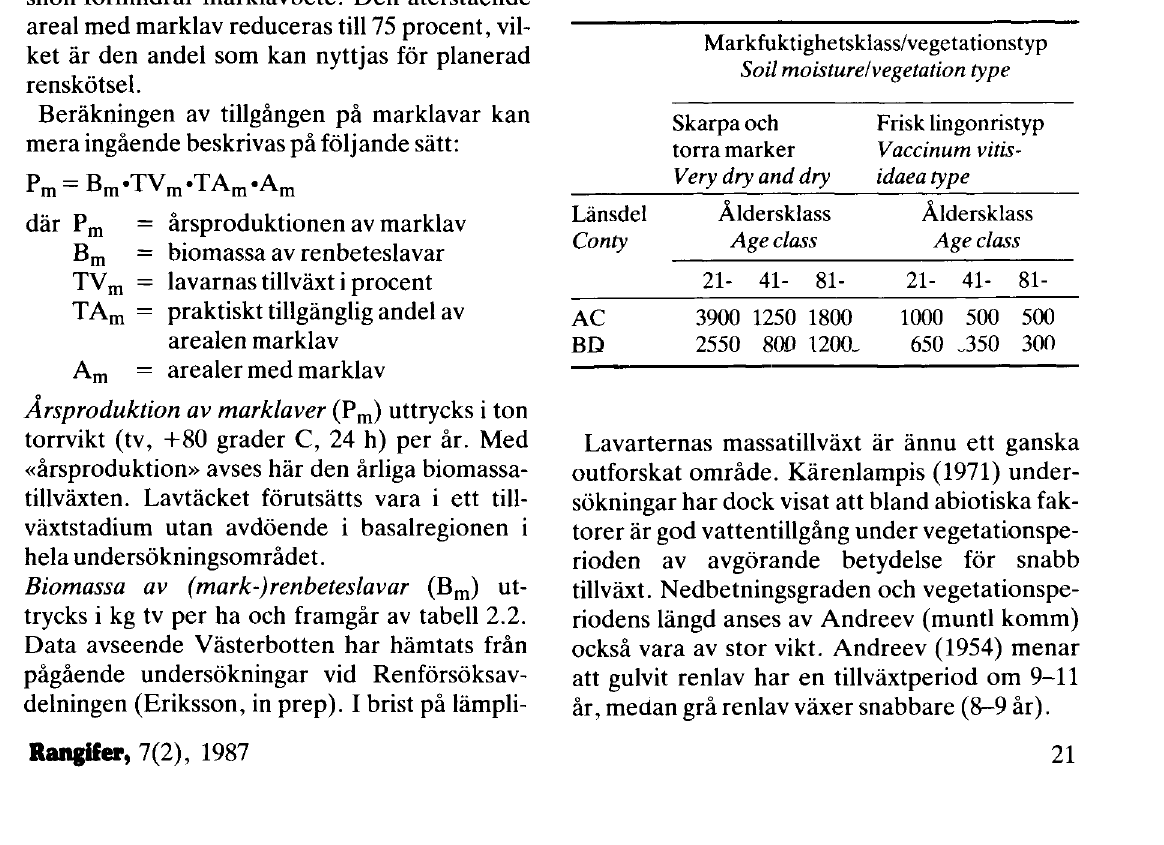
Tabell 2.2. Biomassa av markrenbeteslavar i kg torr vikt per ha for markfuktighetsklasser, ve- getationstyper och